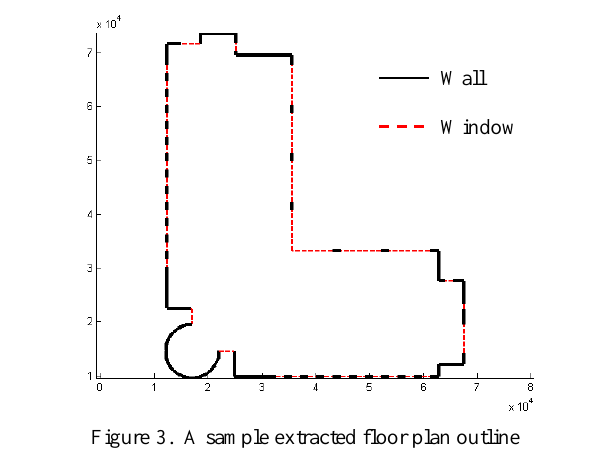
Figure 3. A sample extracted floor plan outline